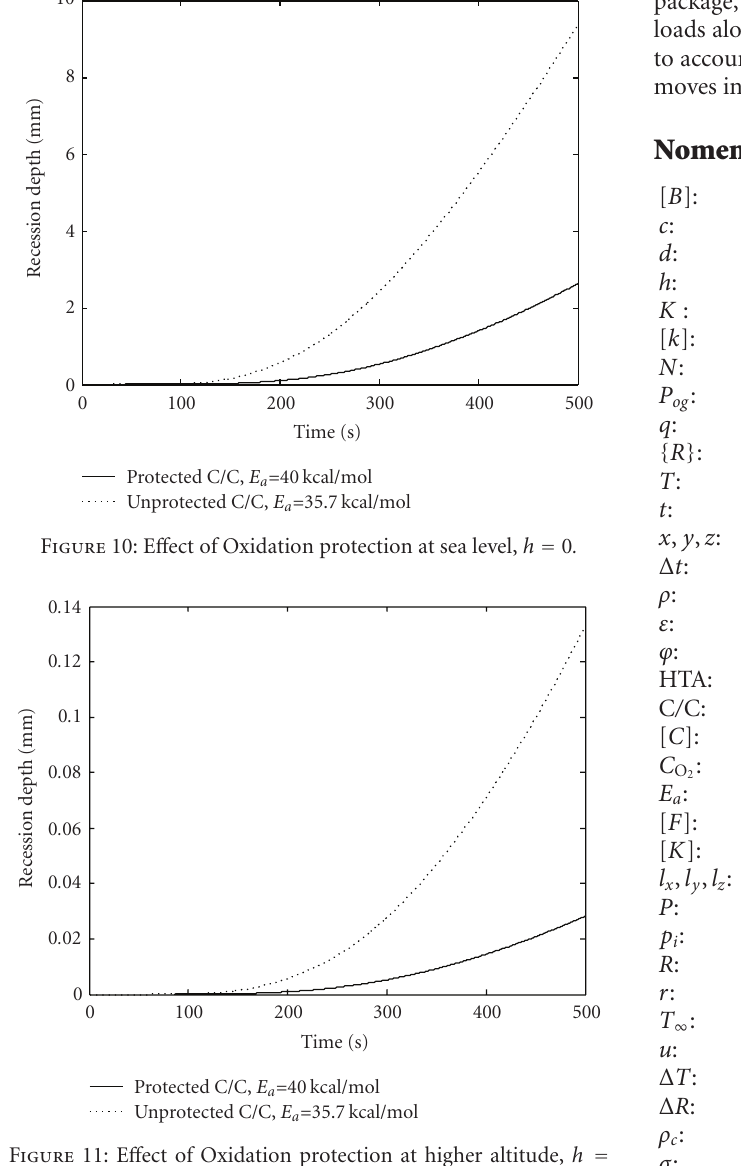
Figure 11: E ff ect of Oxidation protection at higher altitude, h = 32 .